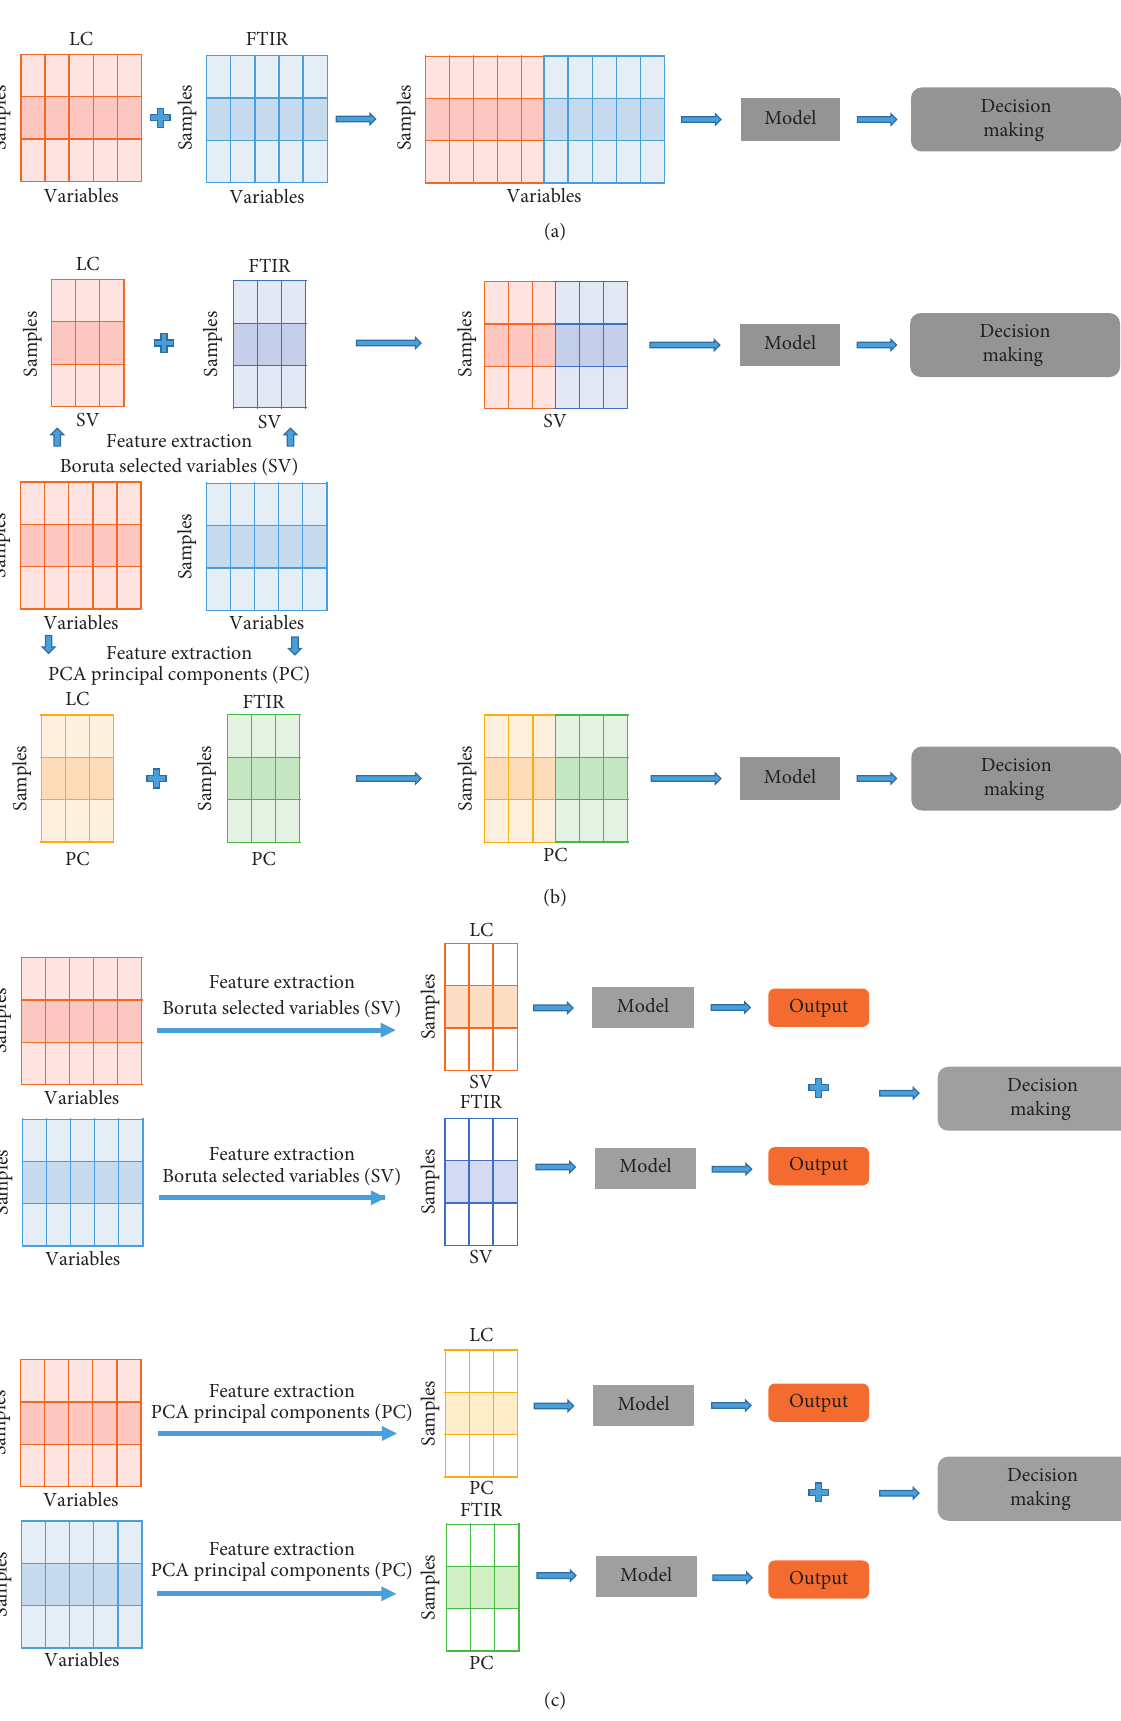
Figure 1: The schemes of data fusion strategies. (a) Low-level data fusion. (b) Mid-level data fusion. (c) High-level data